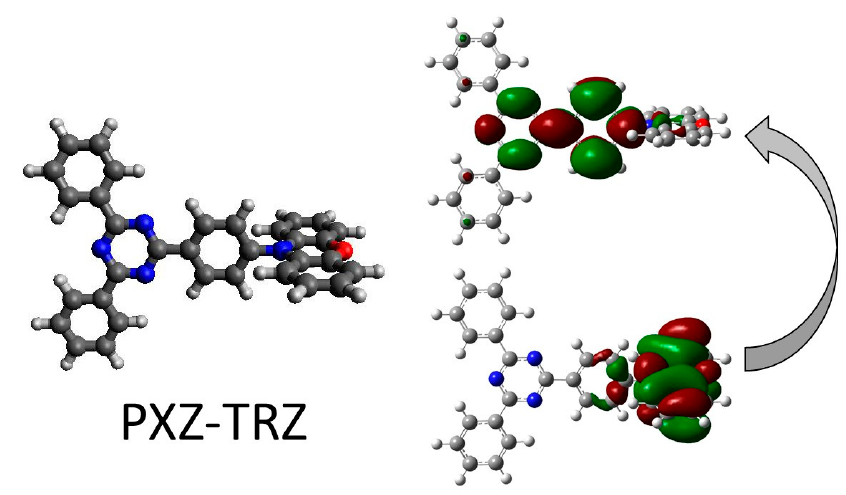
Figure 3. Left : Chemical structure of 2-phenoxazine-4,6-diphenyl-1,3,5-triazine (PXZ-TRZ), a commercially available green emitter that is widely used for TADF and exhibits external quantum efficiencies up to 21% [16]. Right : Isocontour plots of the HOMO (top) and LUMO (bottom) orbitals, with the green and red color of the lobes denoting their different sign. An excited state—S 1 or T 1 — created mostly by a HOMO-to-LUMO one-electron promotion will involve some degree of intramolecular charge-transfer character due to the spatial localization of both orbitals on different molecular moieties, D and A, respectively.